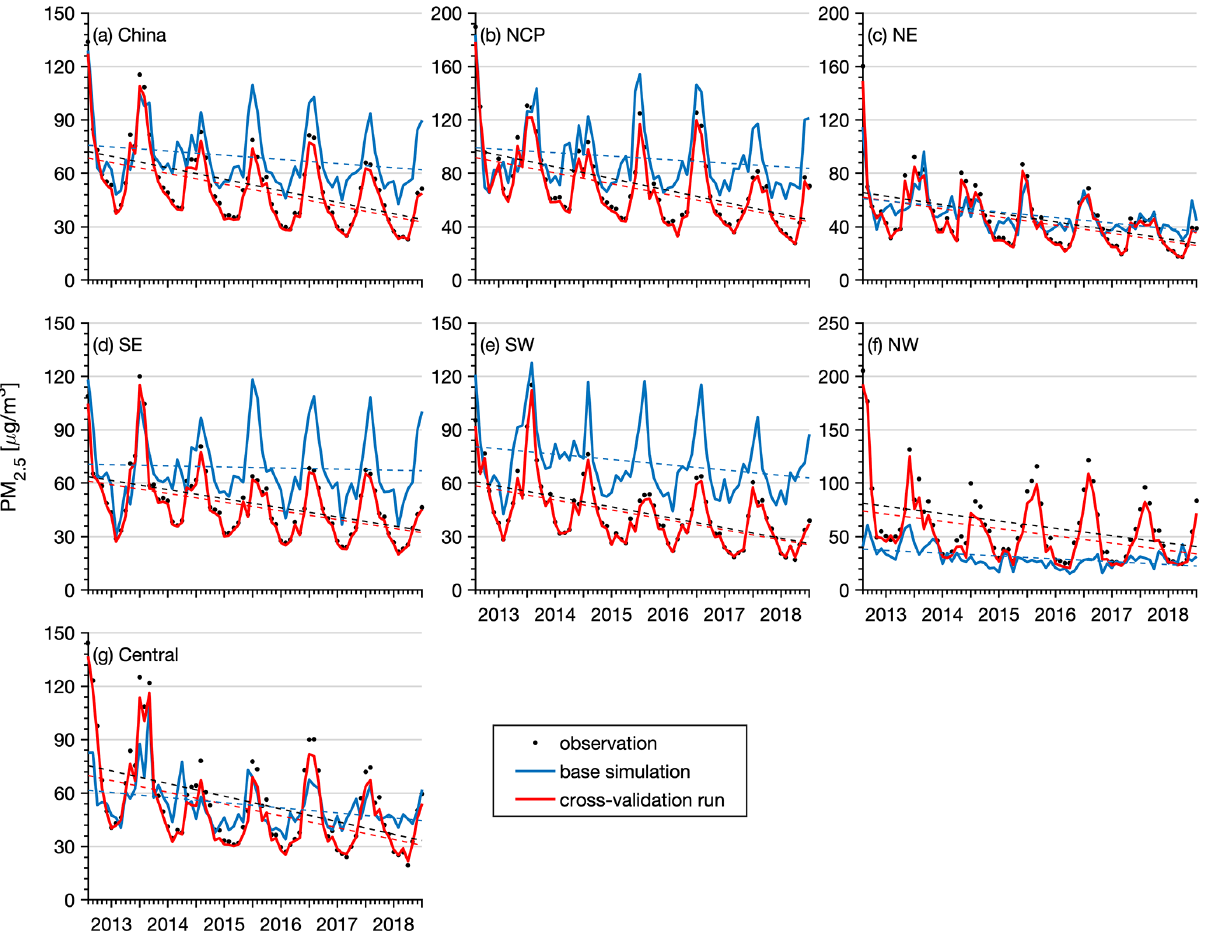
Figure 7. Time series of the monthly mean PM 2 . 5 concentrations in (a) China, (b) NCP, (c) NE, (d) SE, (e) SW, (f) NW, and (f) central regions obtained from the cross-validation run (red line), base simulation (blue line), and observations (black dots).